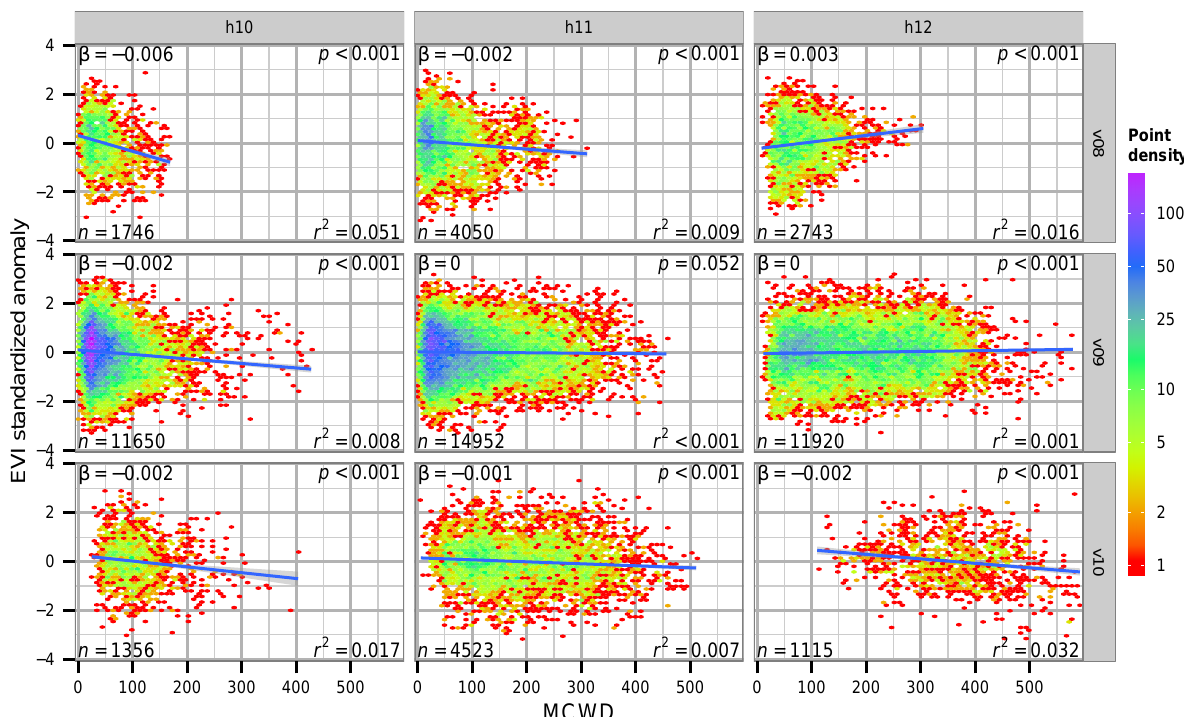
Figure 4: Tile-based scatterplots and regressions of September BRDF-adjusted EVI seasonal anomalies against MCWD, EVI anomalies dimensionless, MCWD in mm, plot grid pattern hints at spatial pattern of MODIS tiles, blue lines are linear regression models, numbers are characteristics of linear models per tile ( β is the regression slope), shaded areas are 95%-confidence intervals for regression lines, density color scale is